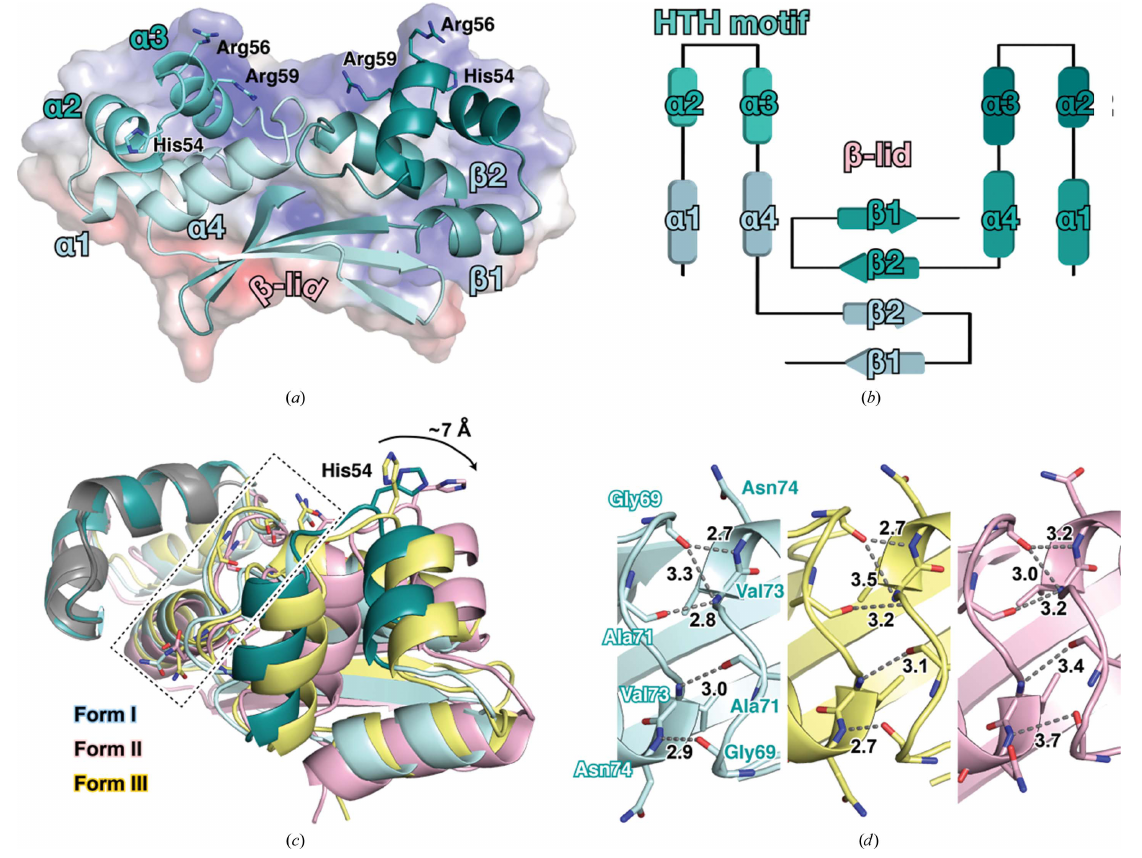
Figure 1 Crystal structure of Mt HigA2. ( a ) Crystal structure of the Mt HigA2 dimer in ribbon representation. The two monomers are coloured light and dark cyan. The HTH motif is highlighted in darker colours. Three positively charged side chains on the HTH motif are indicated as sticks. Potential surface charge is indicated in the background, where surfaces are coloured between (cid:2) 10 kcal mol (cid:2) 1 (red) and +10 kcal mol (cid:2) 1 (blue). ( b ) Secondary-structure diagram of the Mt HigA2 dimer. The colours correspond to those in ( a ). ( c ) The three forms of the Mt HigA2 crystal structure when the HTH motifs are aligned. The arrangement of the second HTH motif is diverse. The side chain of His54 moves (cid:5) 7 A˚ depending on the crystal form. ( d ) Detailed view of the dimerization interface enclosed with a dotted box in ( c ). Hydrogen bonds are indicated as grey dotted lines and distances are given in A˚